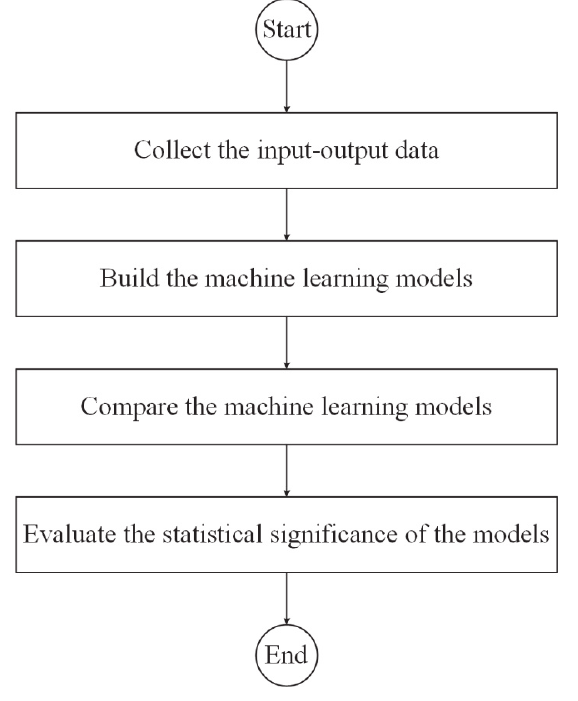
Fig. 1. Framework of the proposed